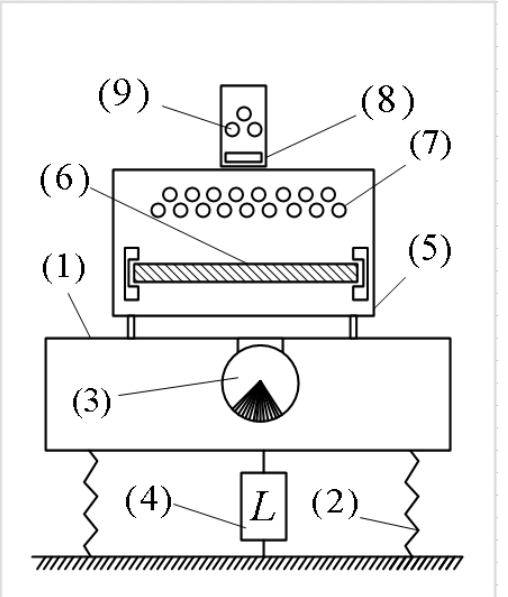
Fig. 1. Schematic diagram of a vibratory technological machine with a sensor. 1- working body surface, 2-elastic element, 3-source of vibration excitation, 4 - motion transformation device, 5-body, 6- workpiece, 7- "working medium", 8 sensor, 9 "model